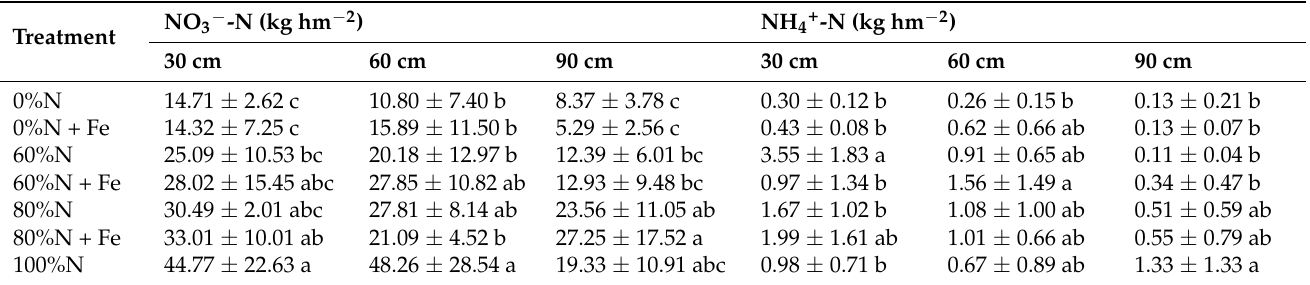
Table 5. Ammonium and nitrate leaching from a paddy field at a soil depth of 30, 60, and 90 cm under various nitrogen fertilization rates with or without iron amendment in